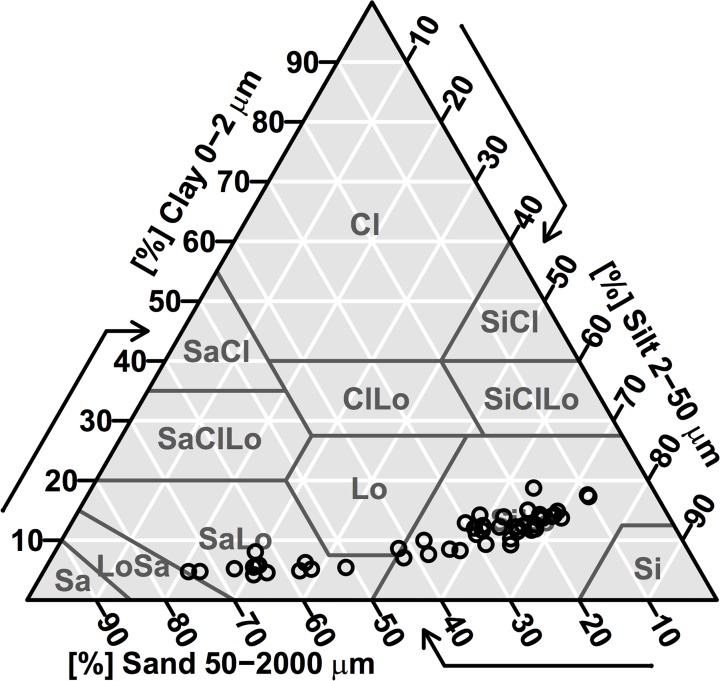
Texture of analyzed soil samples.